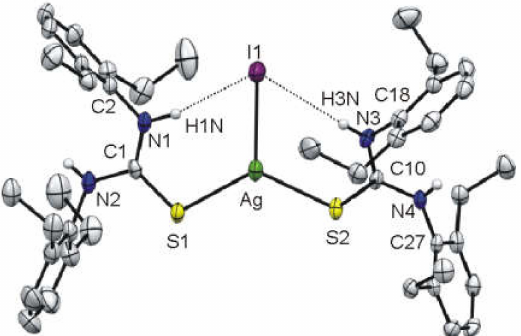
Figure 8. Molecular structure of 2c (ellipsoids correspond to the 50% probability level). Hydrogen atoms, except those of N-H, have been deleted for clarity. Selected bond lengths (Å) and angles ( ◦